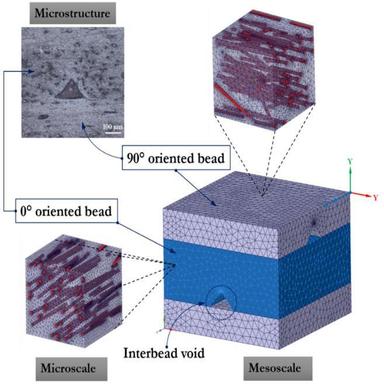
Microscale and mesoscale RVE models meshed using finite elements.